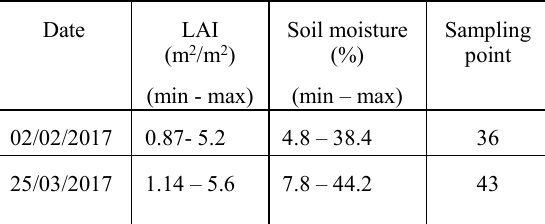
Table 2.Field measurements of wheat crop